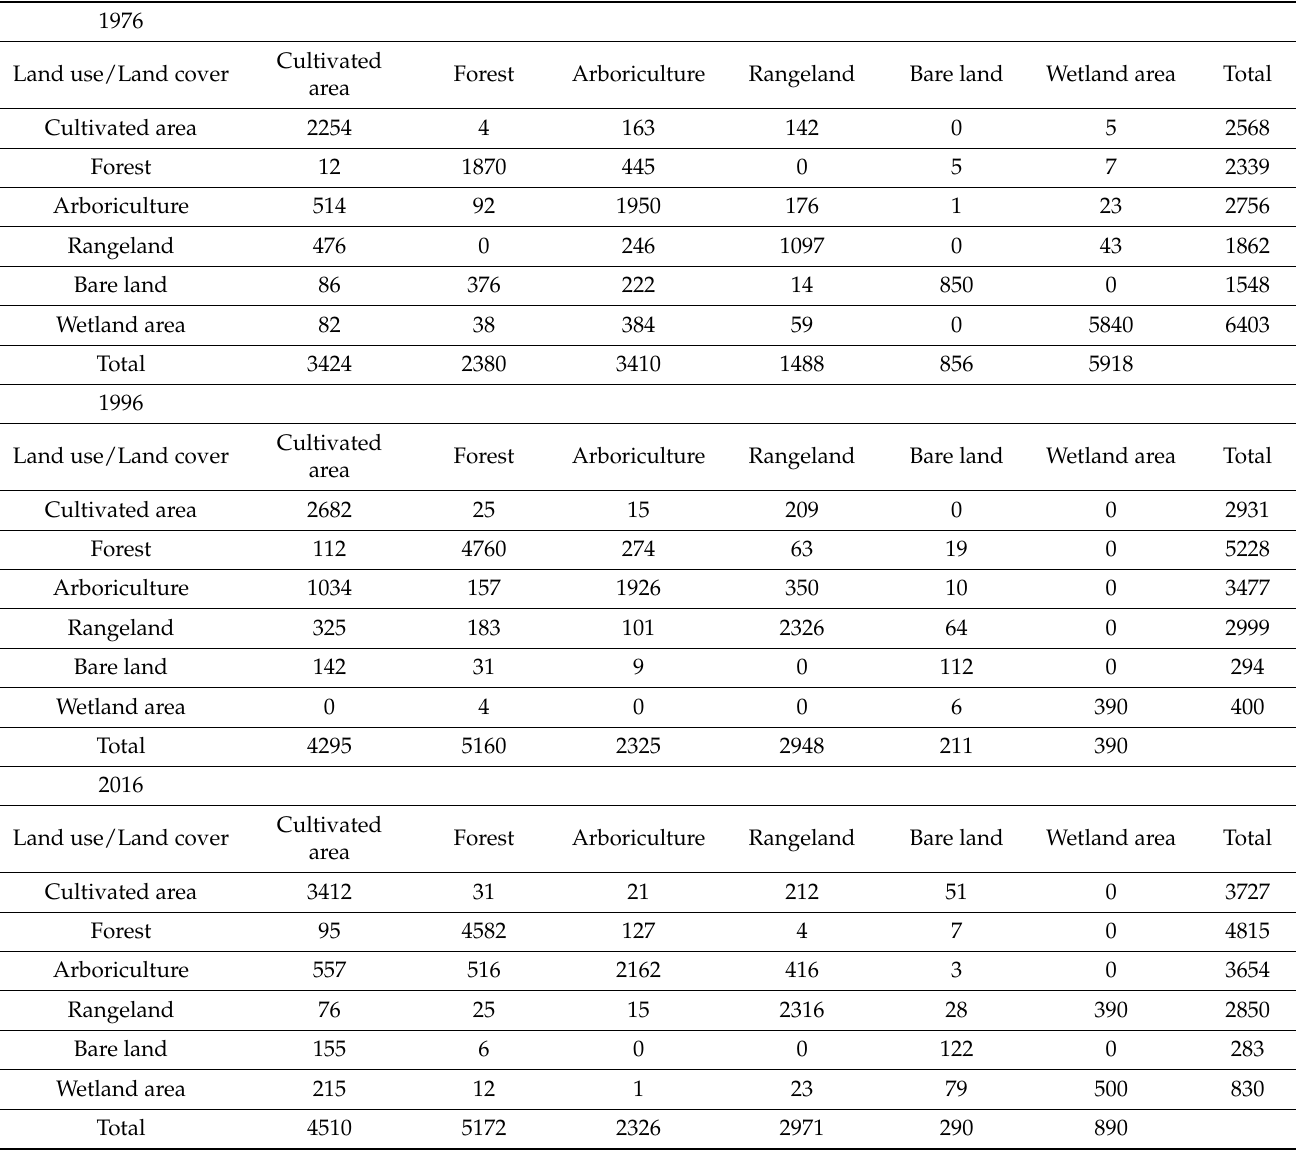
Table 2. Confusion matrix for 1976, 1996, and